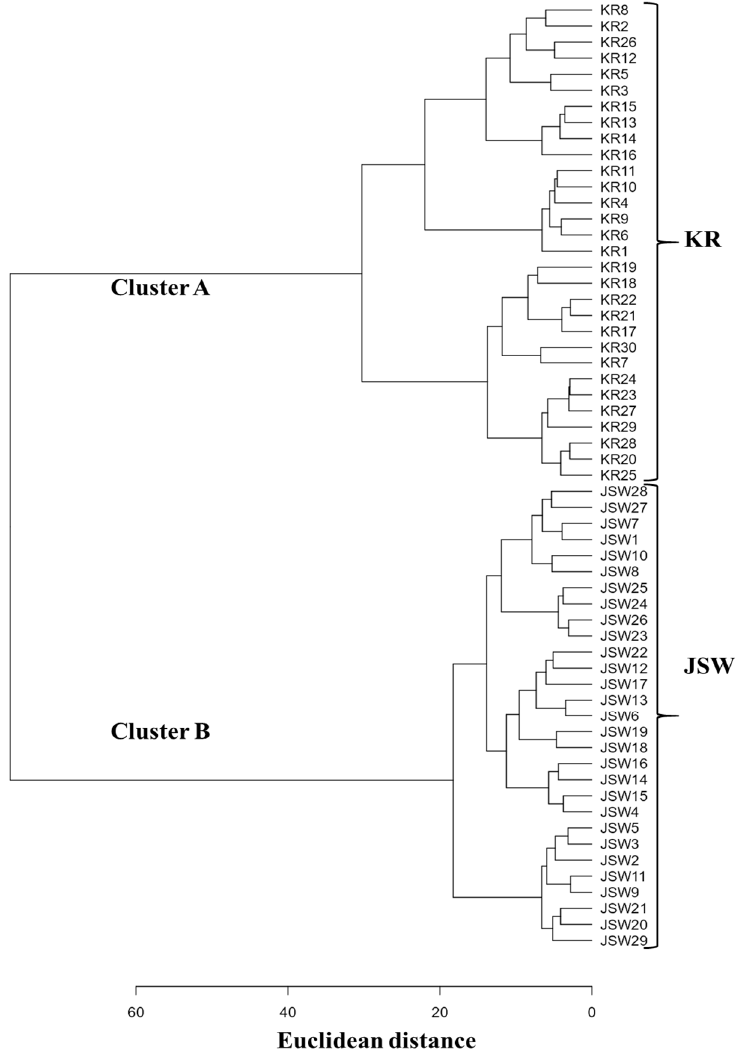
Figure 5. Hierarchical cluster analysis based on 36 morphological characteristics of two L. leichtlinii groups: KR and JSW. KR and JSW accessions showed distinct separation from each other, as KR L. leichtlinii accessions grouped into cluster A and JSW accessions into cluster B.